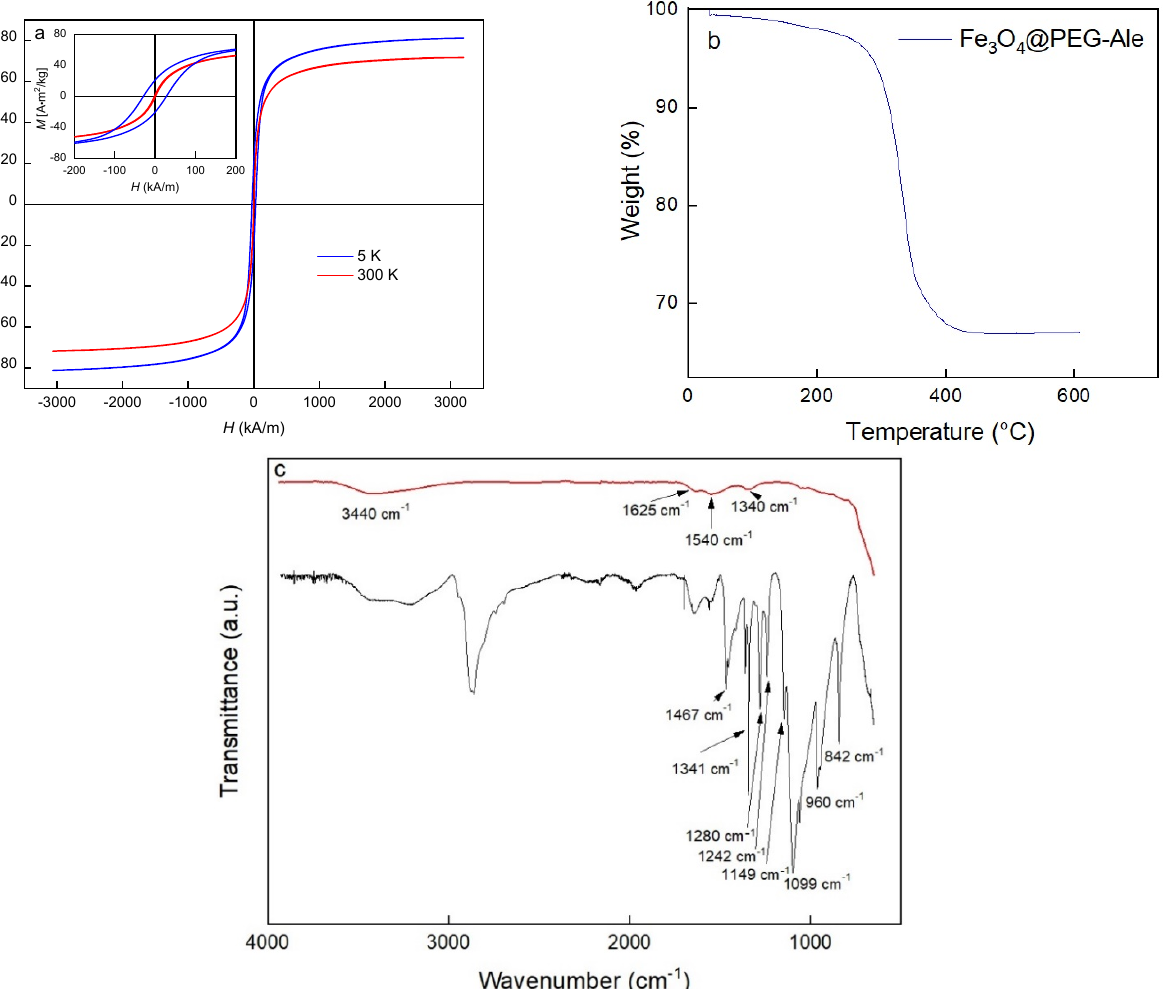
Figure 4. ( a ) Hysteresis loops of pure Fe 3 O 4 nanoparticles at 5 and 300 K, ( b ) thermogravimetric analysis of Fe 3 O 4 @PEG-Ale, and ( c ) FTIR spectra of Fe 3 O 4 ( red ) and Fe 3 O 4 @PEG-Ale nanoparticles ( black ). Thermogravimetric analysis of Fe 3 O 4 @PEG-Ale nanoparticles confirmed the presence of polymer coatings on the iron oxide surface, reaching 33 wt.% (Figure 4b). Moreover, the distance between the attachment points of the PEG-Ale on the particle surface ( d ) and Flory radius ( r f ), respectively, were calculated [31,32] from the grafting density of the polymer (0.54 chains/nm 2 ) and M n of PEG. The r f / d ratio characterized the PEG conformation on particle surface that can be brush-like ( r f / d > 1) or mushroom-like ( r f / d < 1). As the r f / d ratio of Fe 3 O 4 @PEG-Ale particles was 4.45, brush-like conformation of PEG was confirmed. The presence of polymer on surface of nanoparticles was also supported by FTIR (Figure 4c). The spectrum of pure Fe 3 O 4 showed broad band at 3440 and 1625 cm − 1 belonging to O–H stretching vibration and O–H deformed vibration, respectively, proving the presence of coordinated OH groups or water on the particle surface [33]. Peaks at 1540 and 1340 cm − 1 were probably associated with the presence of ammonium carbonate [34] due to the reaction of air CO 2 with ammonia during precipitation of magnetite. The spectrum of PEG-coated nanoparticles showed C-O and C-C stretching and CH 2 rocking at 840 cm − 1 , CH 2 rocking and twisting at 960 cm − 1 , C-O and C-C stretching at 1097 cm − 1 , C-O stretching and CH 2 rocking at 1140 cm − 1 , CH 2 twisting at 1241 and 1278 cm − 1 , CH 2 wagging at 1341 cm − 1 , and CH 2 scissoring at 1466 cm − 1 . 3.2. Blood Pressure, Heart Rate and Red Blood Cell Parameters MAP and HR of all rats at the beginning of the experiment were 184 ± 3 mmHg and 361 ± 10 bpm ( n = 6–7 per group) and no significant differences between the groups were observed. Administration of Fe 3 O 4 @PEG-Ale did not alter BP and HR, neither during the infusion nor at the end of the experiment compared to the corresponding time-point in the control group (Figure 5a,b). There were no differences in RBC deformability ( n = 3), osmotic resistance ( n = 3) and NO production ( n = 5) by RBCs in rats determined 100 min after administration of Fe 3 O 4 @PEG-Ale nanoparticles, compared to basal levels of these rats (Figure 6).